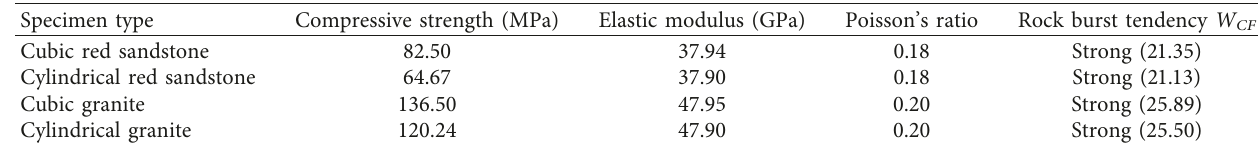
Figure 3: Stress-strain curves of different rock. (a) Red sandstone. (b) Granite. Table 1: The mechanical parameters and rock burst tendency for different types of